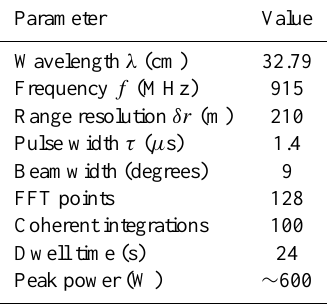
Table 1. Typical operating parameters of the ARRC